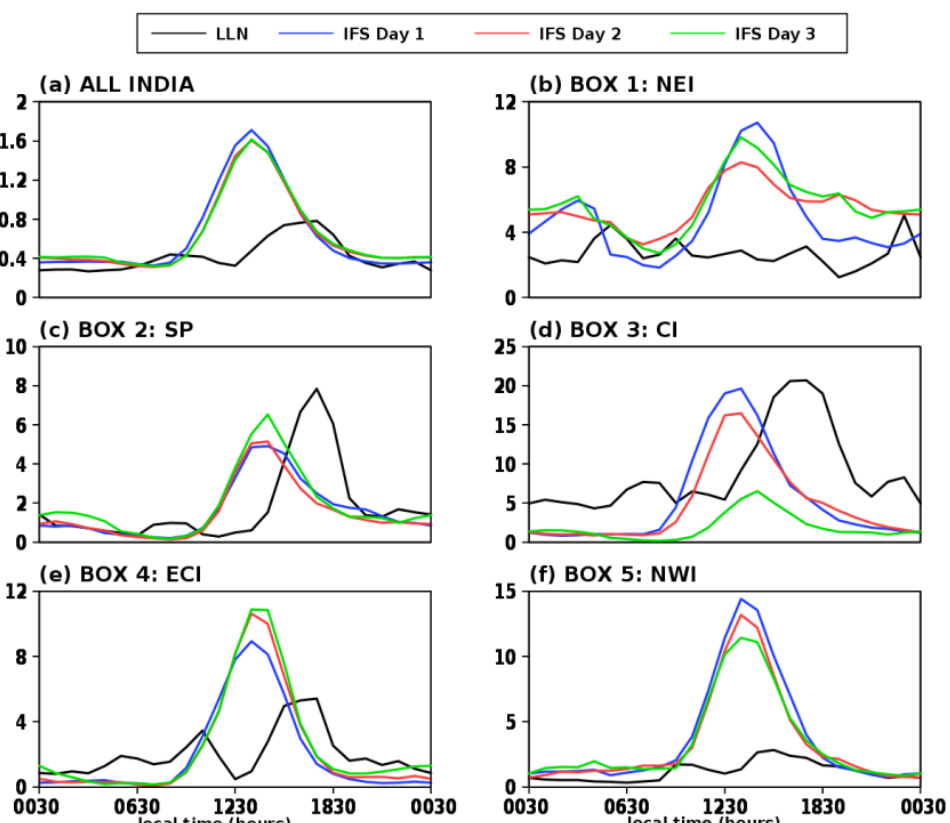
Figure 5. Mean diurnal cycle of flash density ( × 10 − 3 km − 2 day − 1 ) during MAM 2020 for LLN (black) and IFS Day 1 (blue), Day 2 (red), and Day 3 (green) lead times, spatially averaged over ( a ) the Indian subcontinent and ( b – f ) over each predefined subregion.